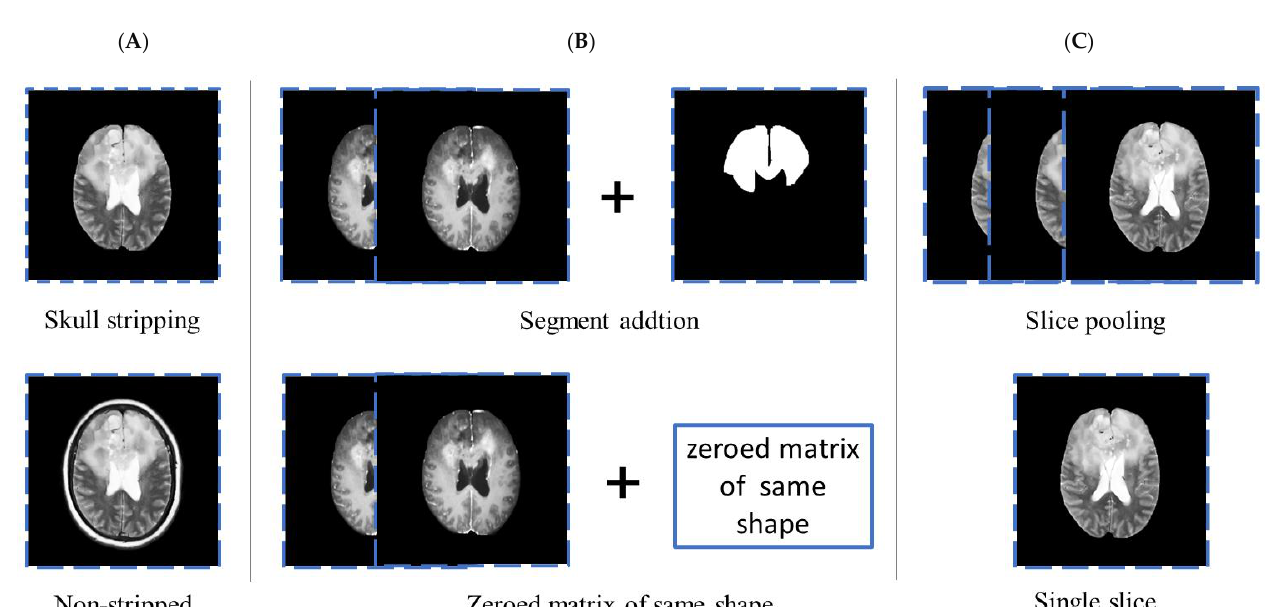
Figure 3. Comparison of different image preprocessing strategies. ( A ) skull stripping or non-stripped strategies. ( B ) Segment addition or replacement by a zeroed matrix of the same shape. ( C ) Slice pooling for a single prediction per patient or individual treatment of each slice.